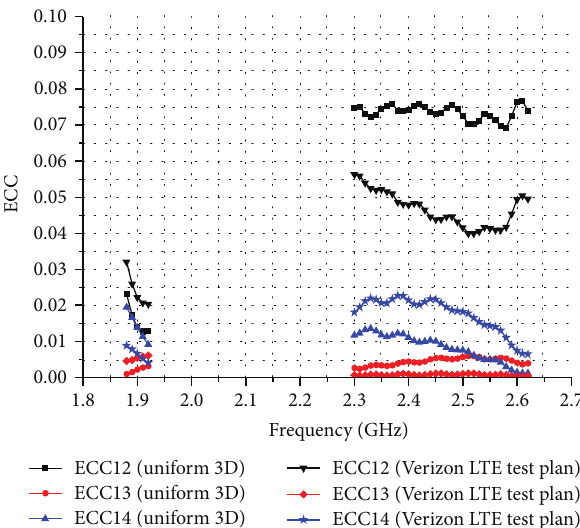
Figure 8: Envelope correlation coefficient between the